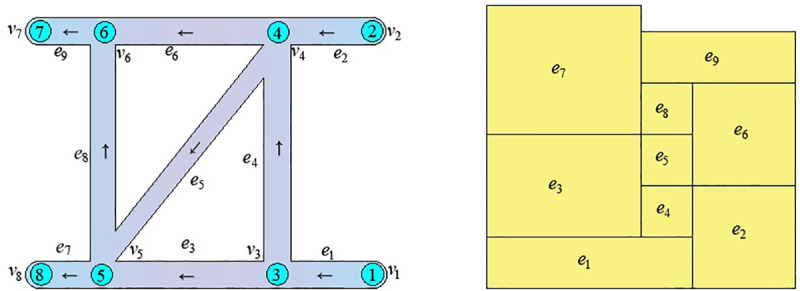
Transformation of network graph and Q-H graph in [14].(a) Ventilation network graph; (b) Q-H graph.